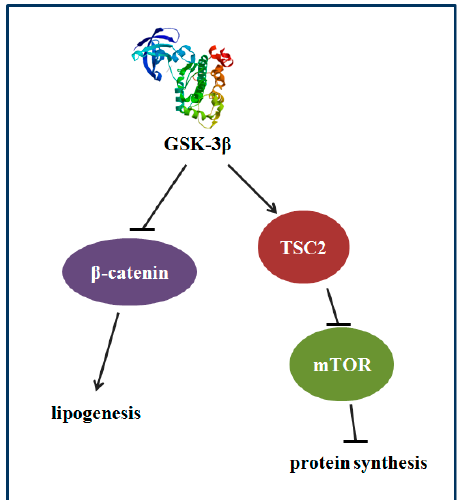
Figure 9. The proposed mechanism that GSK-3 β participates in regulating protein synthesis and lipid deposition in zebrafish. GSK-3 β may participate in regulating protein synthesis via TSC2/mTOR signaling and lipid deposition via β -catenin in the muscle of zebrafish.